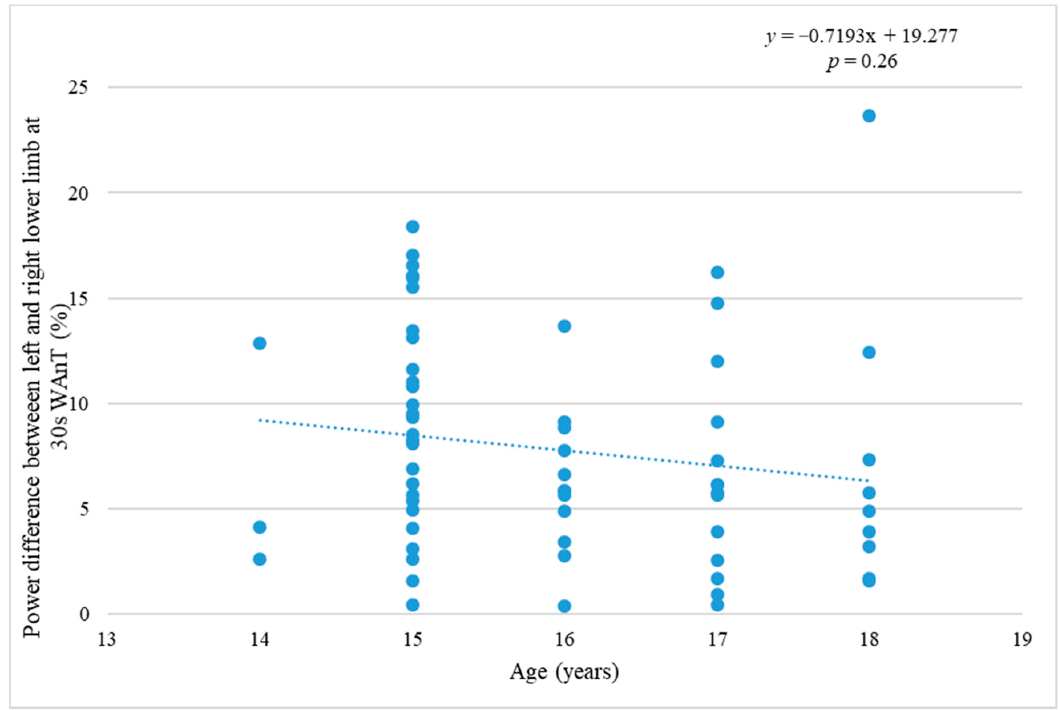
Figure 4. Relation of age and the power difference of individual legs at 30 s WAnT.